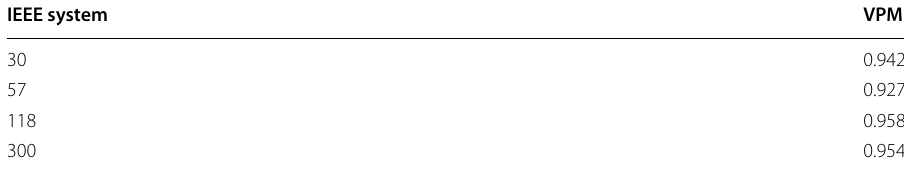
Table 5 Results of VPM for the EMDE attack IEEE